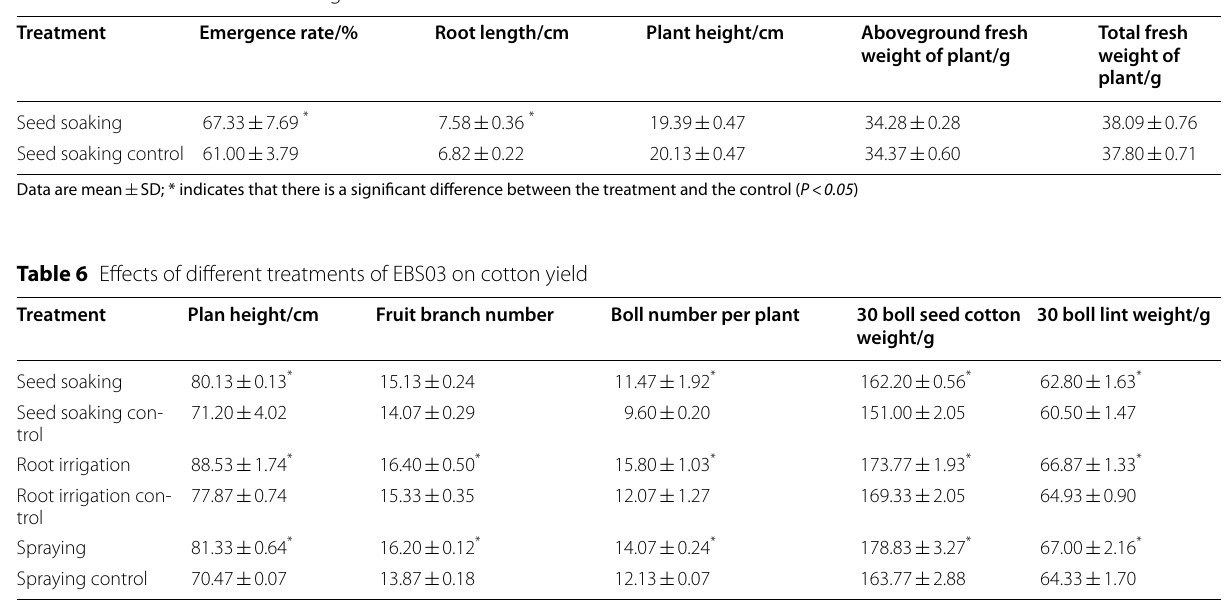
Data are mean SD; * indicates that there is a significant difference between the treatment and the control ( P < 0.05 ). ± Table 7 Effects of different treatments of EBS03 on cotton fiber quality Treatment